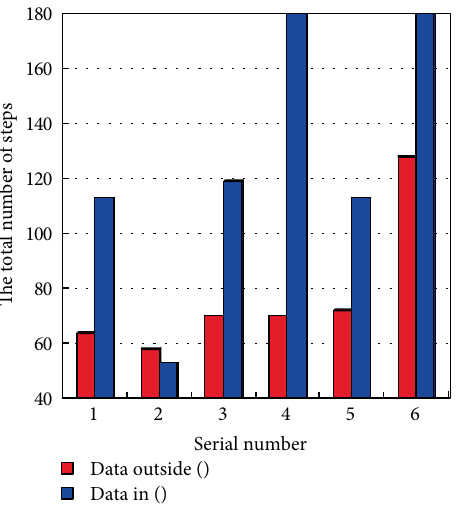
Figure 9: A comparison chart of 𝑠 sum when there are two